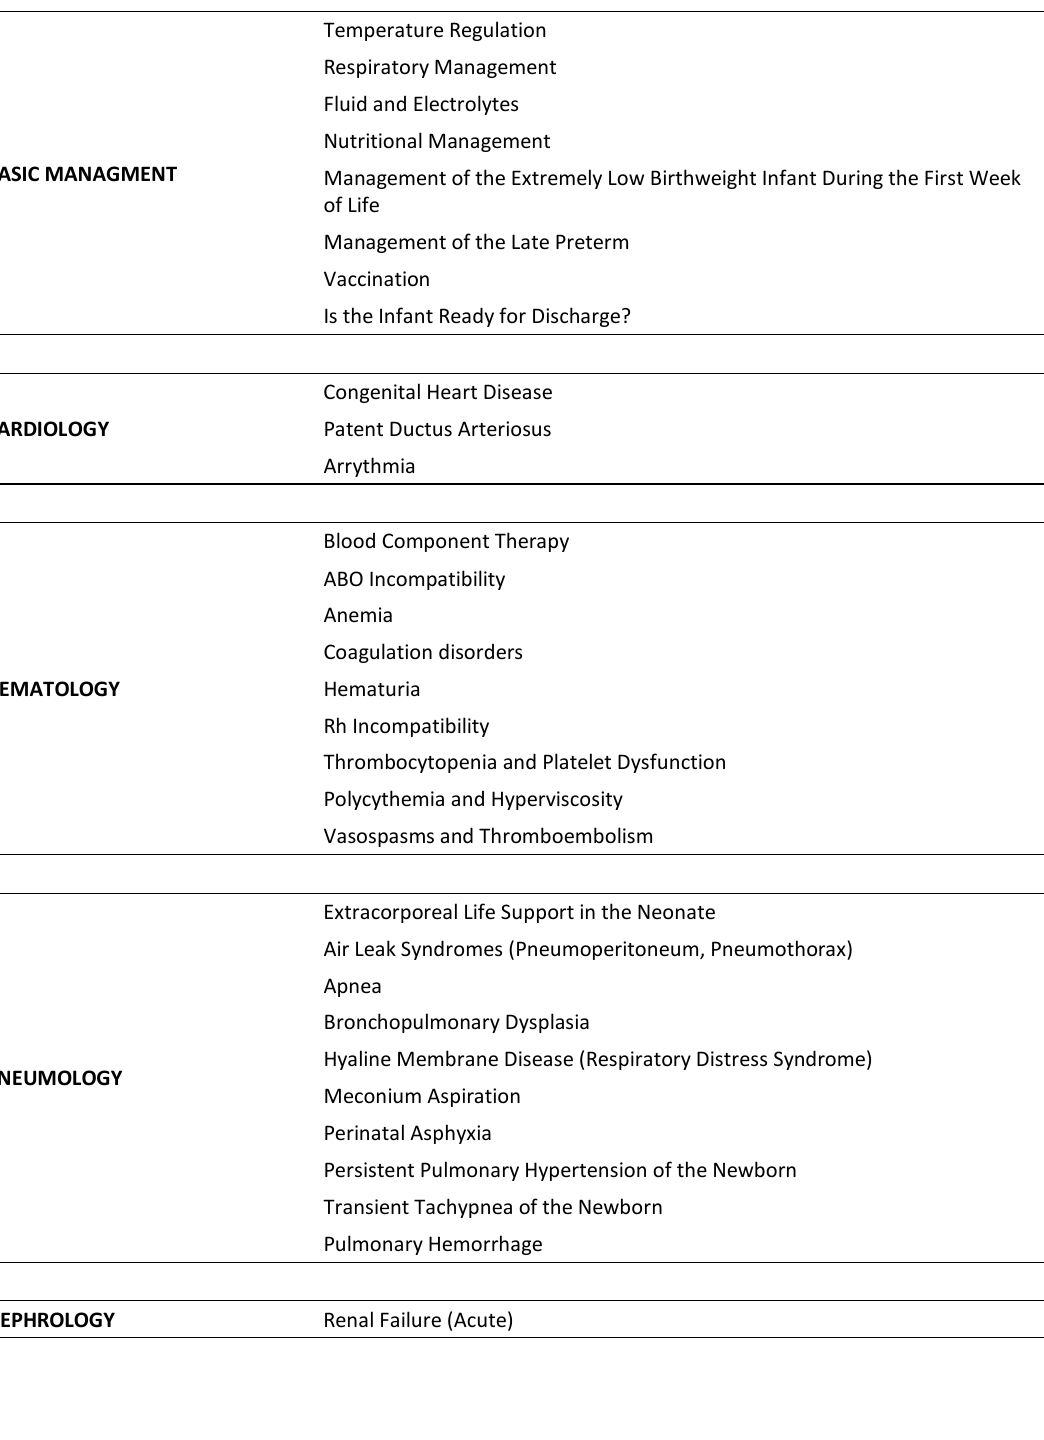
TABLE A1-1 Themes and subthemes included in the literature